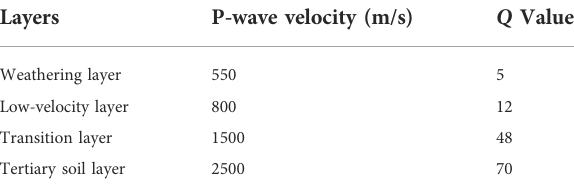
TABLE 2 P-wave velocity and Q values of loess layers.